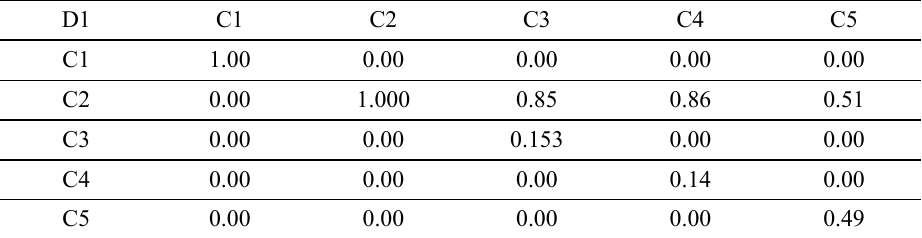
Table 6. The weight matrix of inner dependence for criteria under the Relationship Dimension